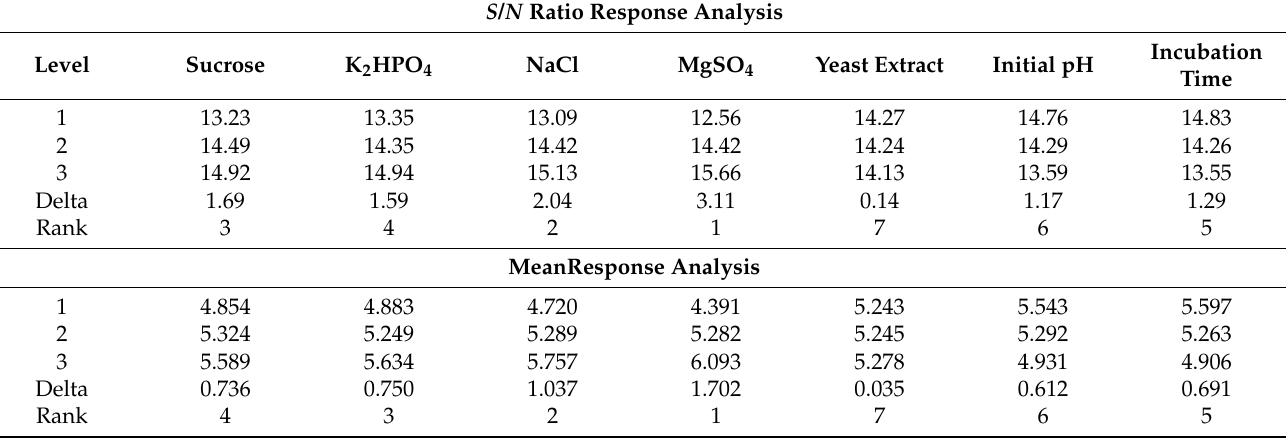
Table 3. Response analysis of S/N ratio and means of Taguchi array of pullulan biosynthesis by A. pullulans